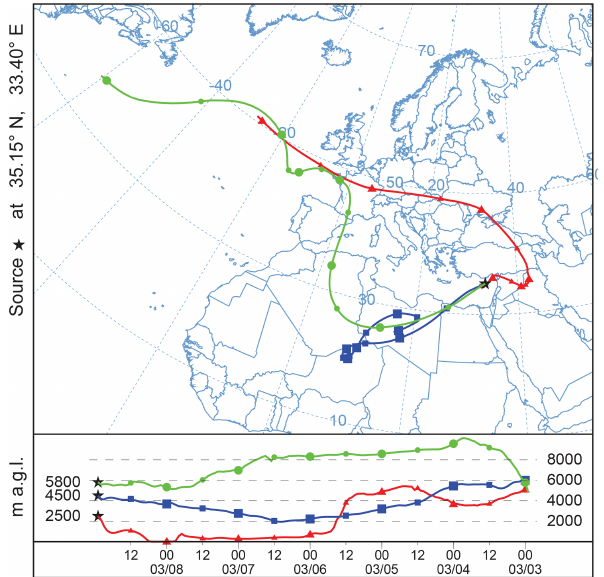
Figure 15. HYSPLIT backward trajectories for 6d arriving at Nicosia, Cyprus, on 8 March 2015 at 23:00UTC (see Fig. 5a and b). The computations are based on GDAS0.5 meteorological fields. Arrival heights are 2500m (red, Middle Eastern dust layer), 4500m (blue, Saharan dust layer), and 5800m (green, Saharan dust layer).